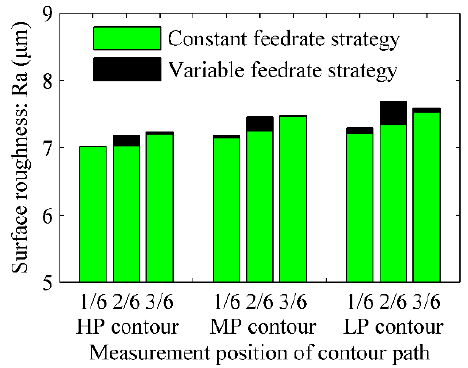
Figure 17. Surface roughness for each contour tool path with and without feed rate variation.